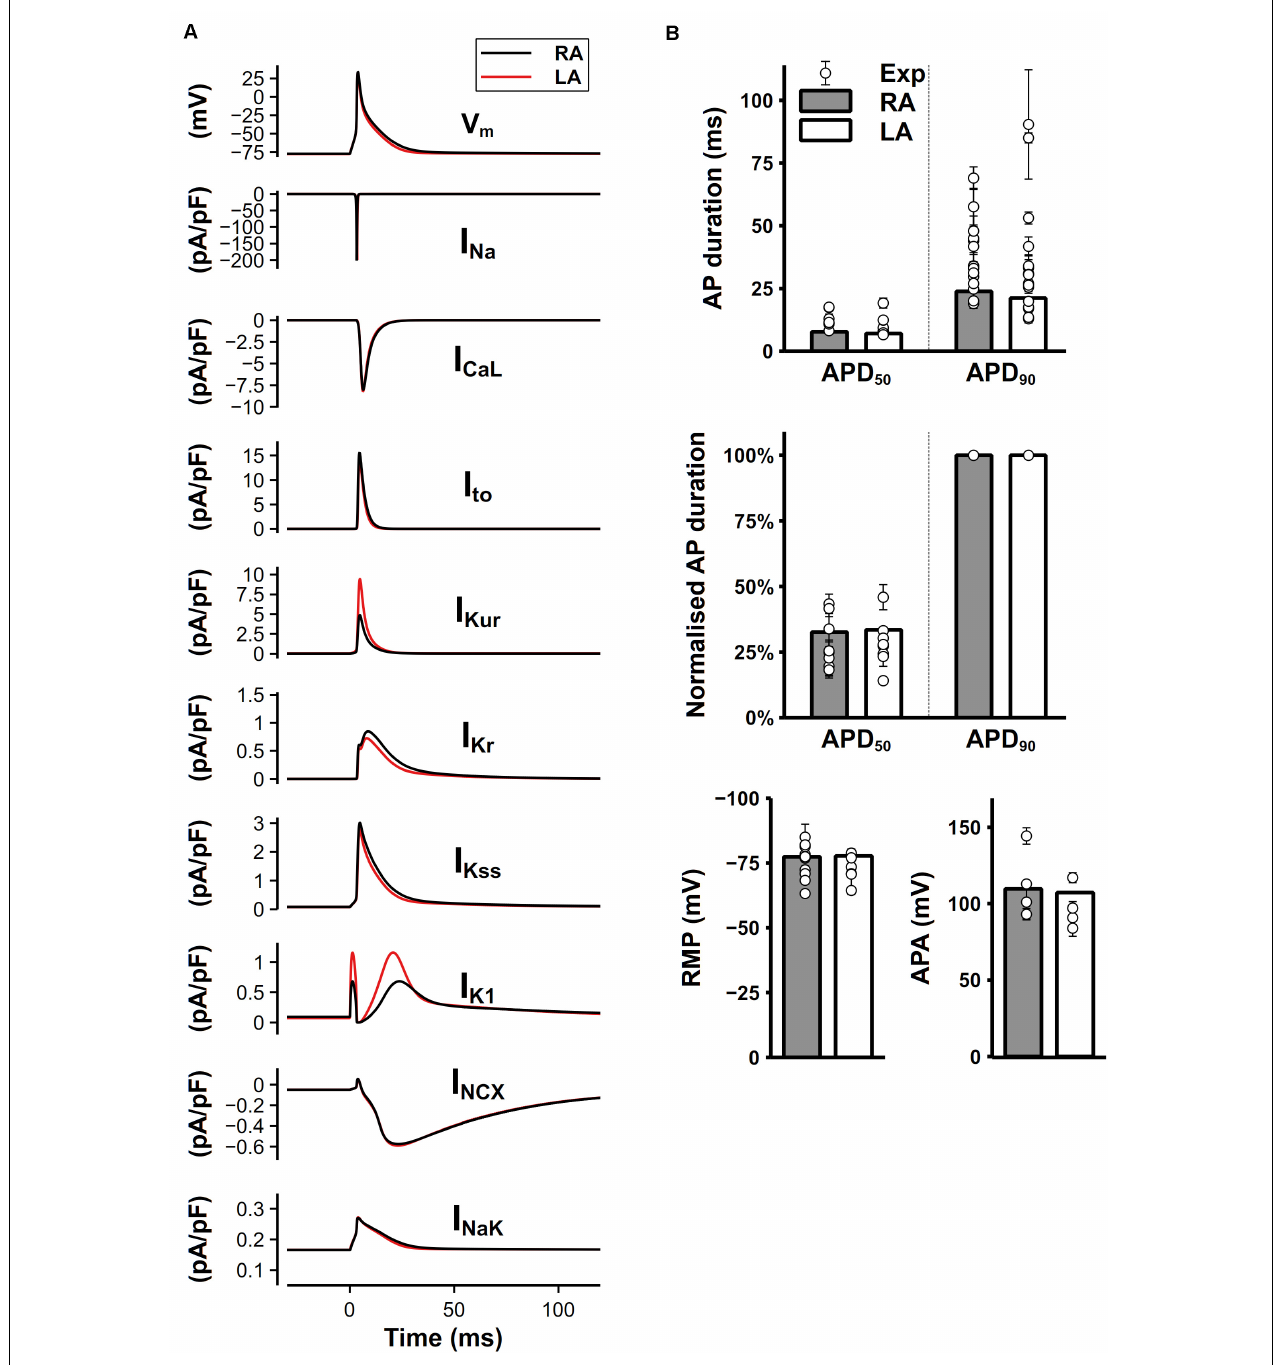
FIGURE 8 | Simulated mouse atrial APs, currents and AP characteristics. (A) Mouse left and right atrial APs (shown as the membrane potential (V m ) against time) and major underlying currents simulated at steady state with 1-Hz pacing. (B) Comparison between simulated (bars) and experimental records (circles) of AP